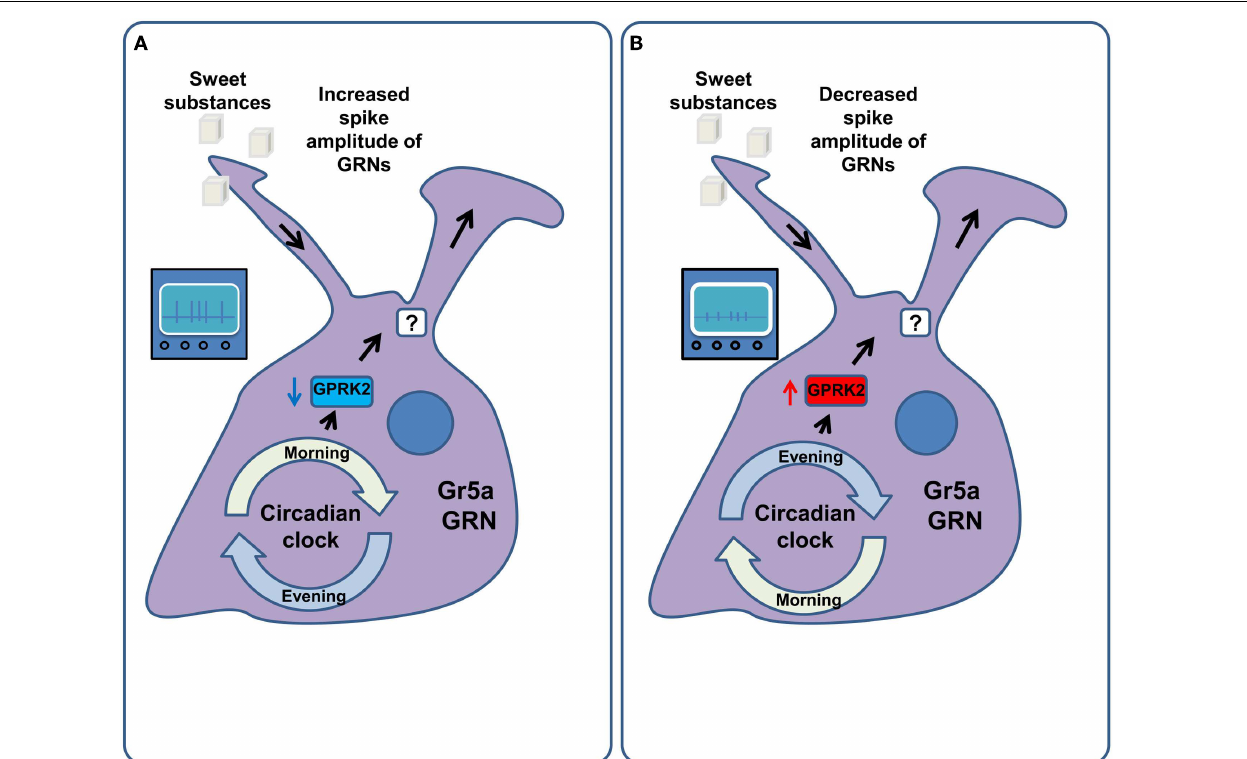
of their action potentials. As a result flies consume more food in the morning. (B) In the evening and at night the activity of GPRK2 is increased, leading to a decrease in the sensitivity of Gr5a GRNs to sucrose.This is mediated by decreasing the spike width and amplitude of these GRNs. As a result flies consume less food in the